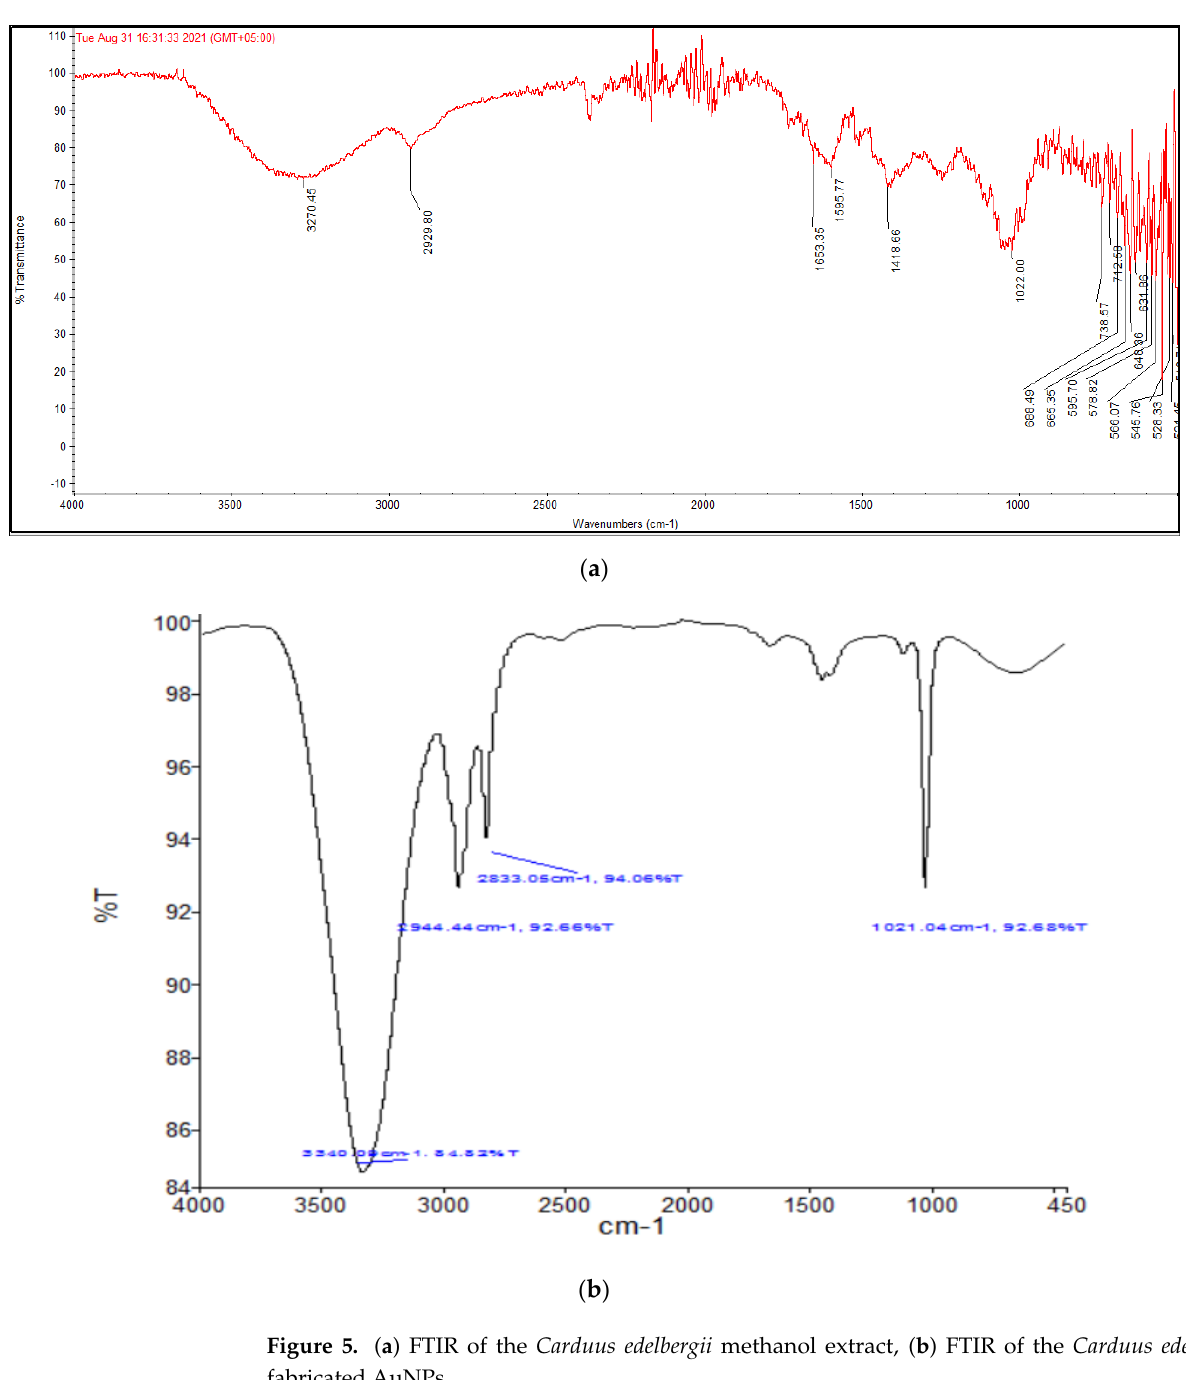
Figure 5. ( a ) FTIR of the Carduus edelbergii methanol extract, ( b ) FTIR of the Carduus edelbergii fabricated AuNPs.